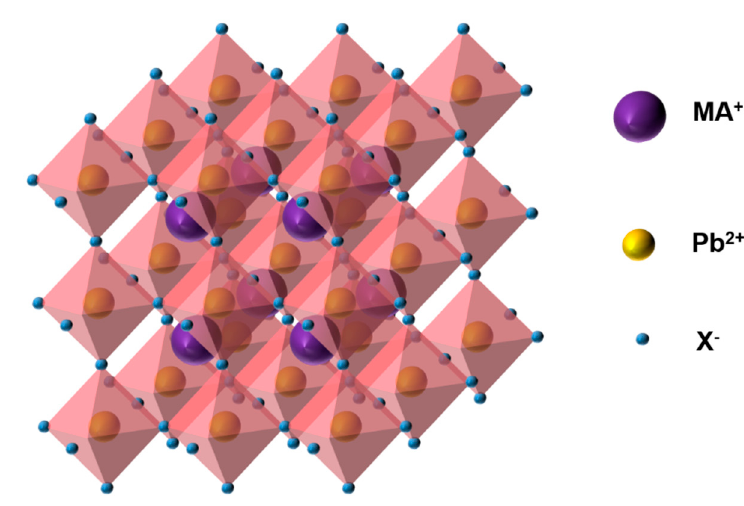
Figure 1. Structure of MAPbX 3.